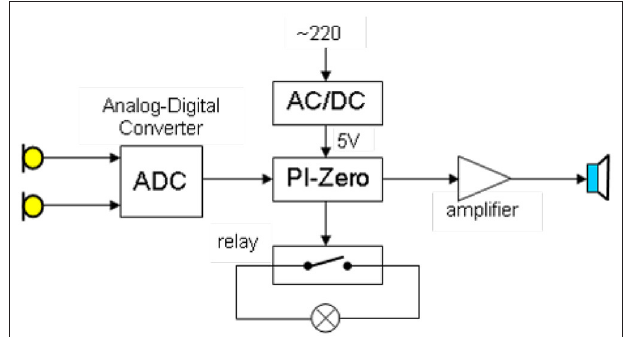
FIGURE 3 | Components of a client